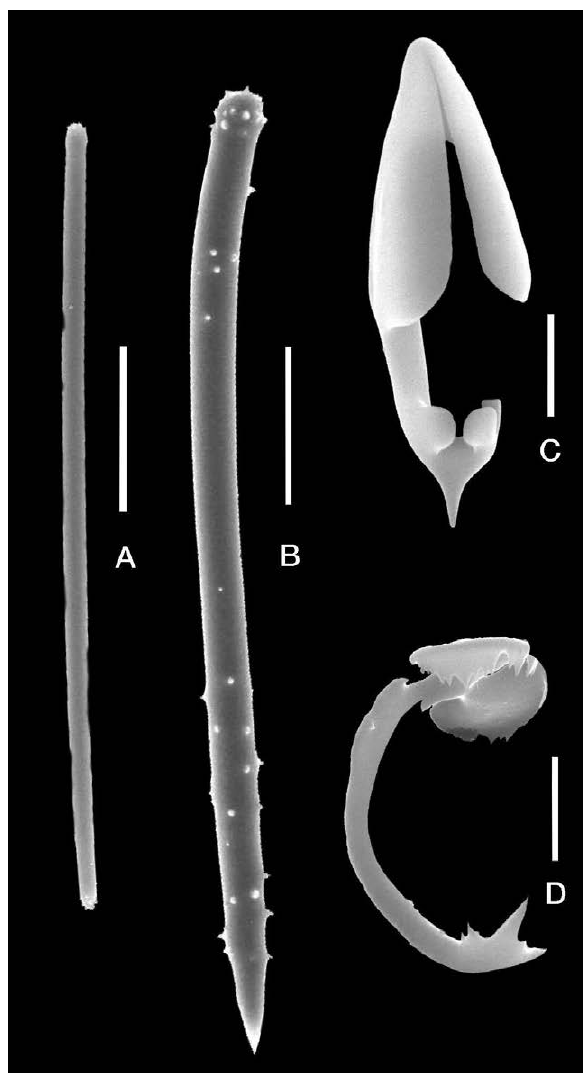
Fig . 12. – Iophon indentatum Wilson, 1904. A, Ectosomal tylote with microspined heads. B, Choanosomal acanthostyle. C, Aniso- chela. D, Bipocillae. Scale: A, 40 μm; B, 30 μm; C, 3 μm; D, 5